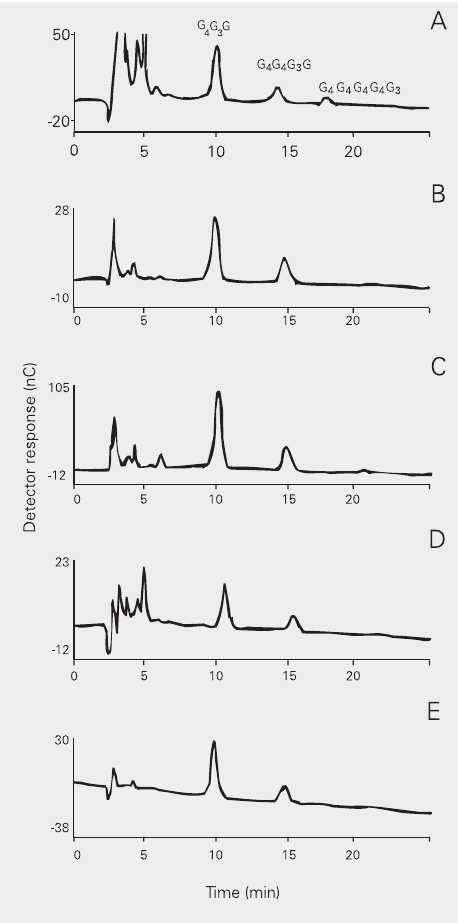
Figure 1. High-performance an- ion exchange chromatography with pulsed amperometric de- tection analysis of ß-glucan after hydrolysis of the 4 M KOH frac- tion with endo-glucanase from Bacillus subtilis. A , Young leaves; B , expanded leaf blade; C , sheath; D , stem of Rhyn- chelytrum repens ; E , maize. G 4 G 3 G = trisaccharide, G 4 G 4 G 3 G = tetrasaccharide and G 4 G 4 G 4 G 4 G 3 = pentasaccharide. The subscripts represent the type of linkage between two glucoses (G): 4 represents a ß-1,4 linkage and 3 a ß-1,3 linkage. nC = nano Columbs.